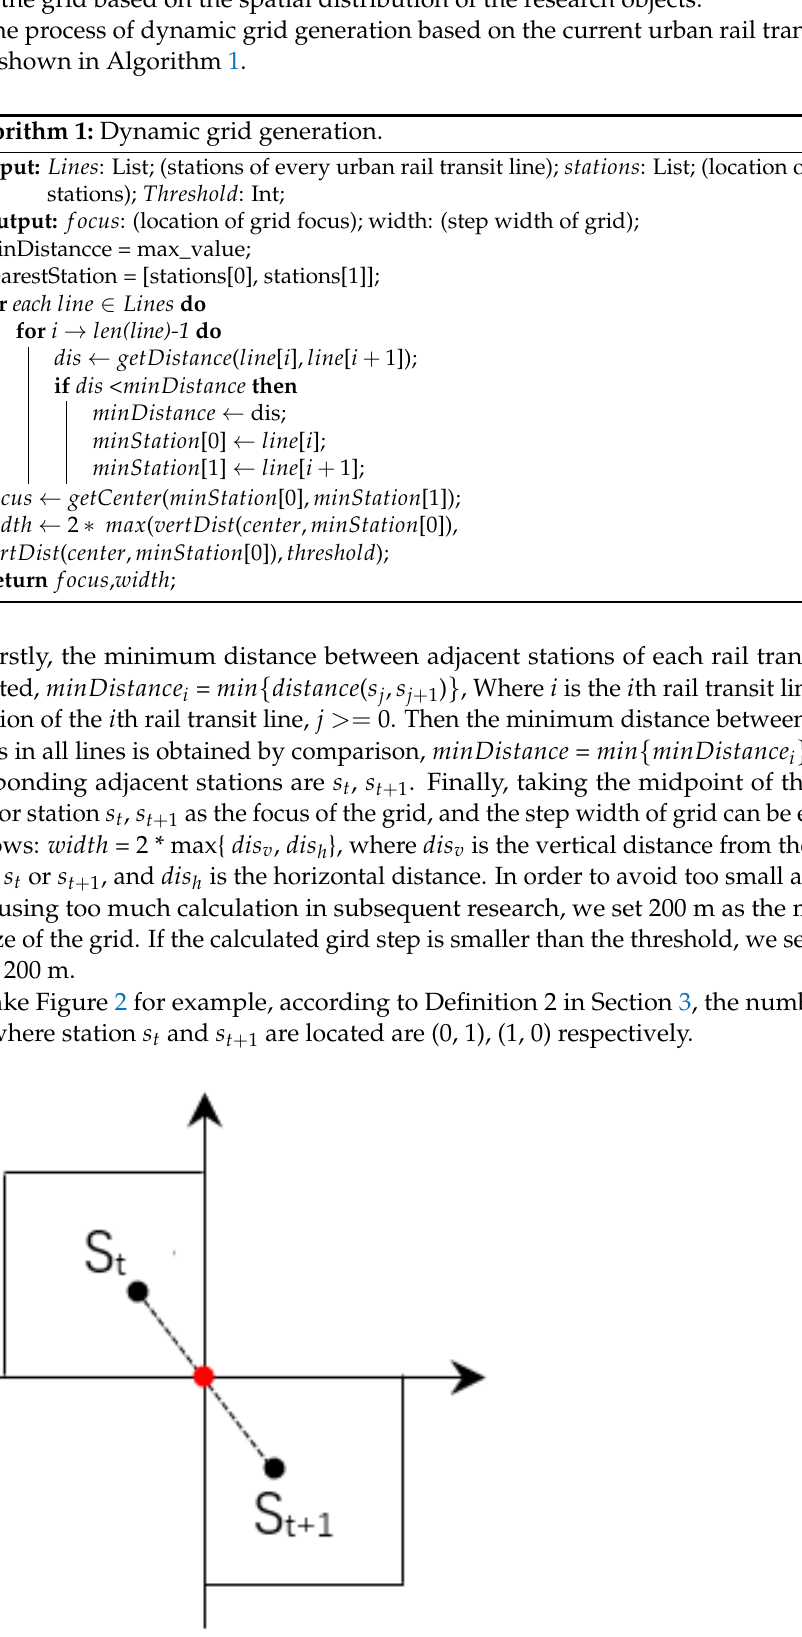
Figure 2. Example of dynamic grid